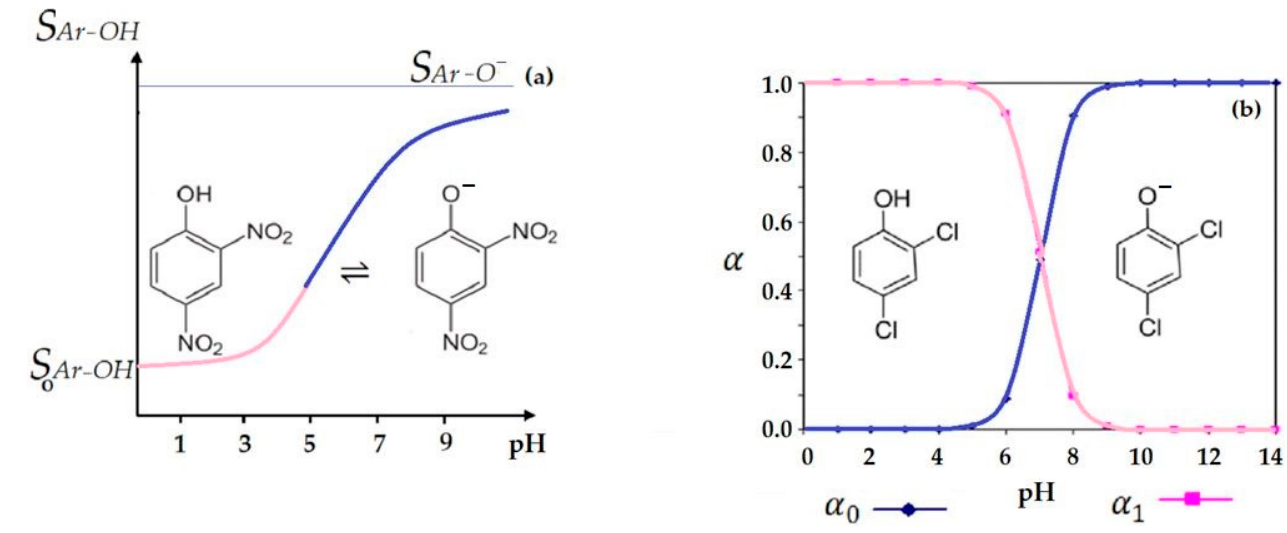
Figure 11. The behavior of phenolic derivatives in the aqueous environment: ( a ) solubility variation of 2,4–dinitrophenol (DNP) depending on pH; ( b ) the degree of formation of 2,4–dichlorophenol (DCP).